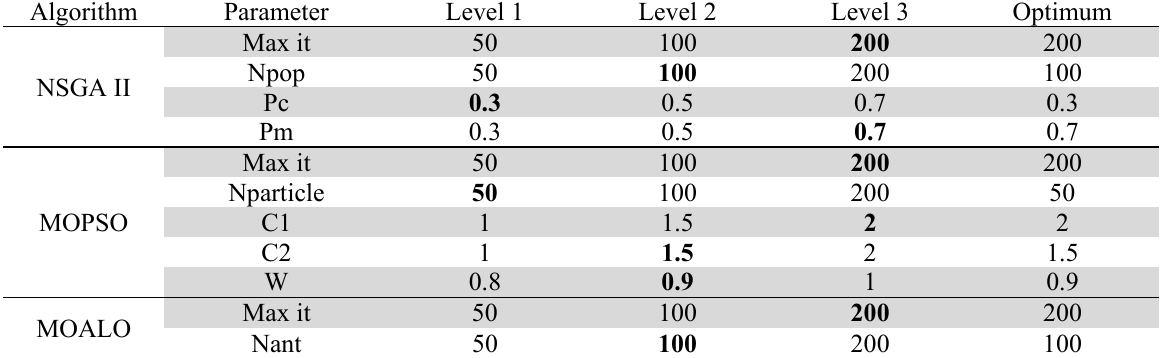
The value of proposed and optimized parameters of meta-heuristic algorithms